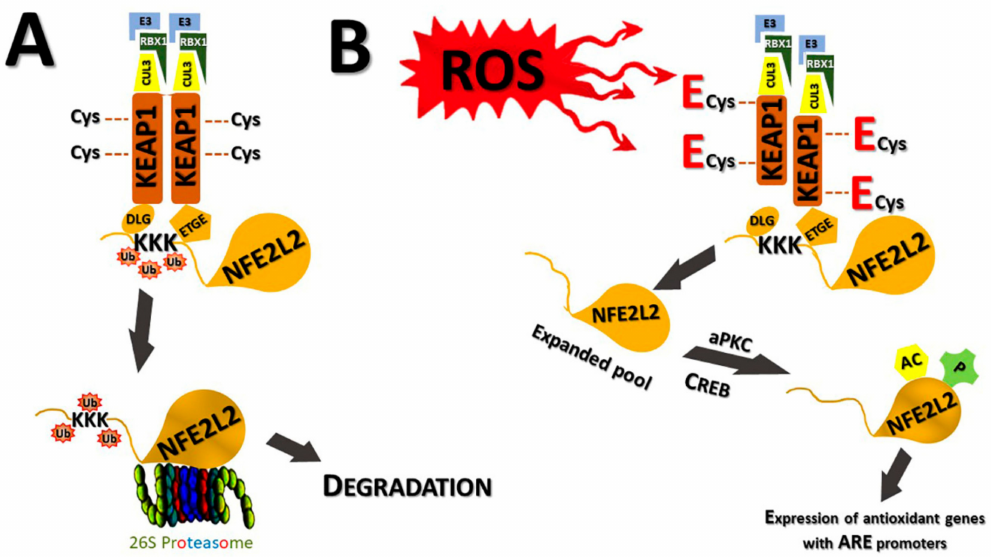
Figure 2. The canonical KEAP1 / NFE2L2 antioxidant signalling pathway, induced by electrophilic ligands. ( A ) In basal conditions, KEAP1 dimer and NFE2L2 are bound together, with the DLG and ETGE amino acid domains of NFE2L2. This sustains the constant ubiquitination of NFE2L2 and its resulting turnover by proteasomal degradation. ( B ) In OS, Cys-residues of KEAP1 bind electrophilic ligands (E), leading to a loosening of the DLG-binding, a subsequent cessation of ubiquitination and finally the detachment of NFE2L2 from the complex. After its transfer to the nucleus, NFE2L2 acts as a transcription factor for ARE-dependent antioxidant genes. Abbreviations: CUL3, adaptor component Cullin 3; DLG, Asp-Lys-Gly motif; E3, E3 ubiquitin ligase; ETGE, Glu-Thr-Gly-Glu motif; KKK, lysine-rich domain; RBX1, RING box protein 1. Other abbreviations are explained in the list of